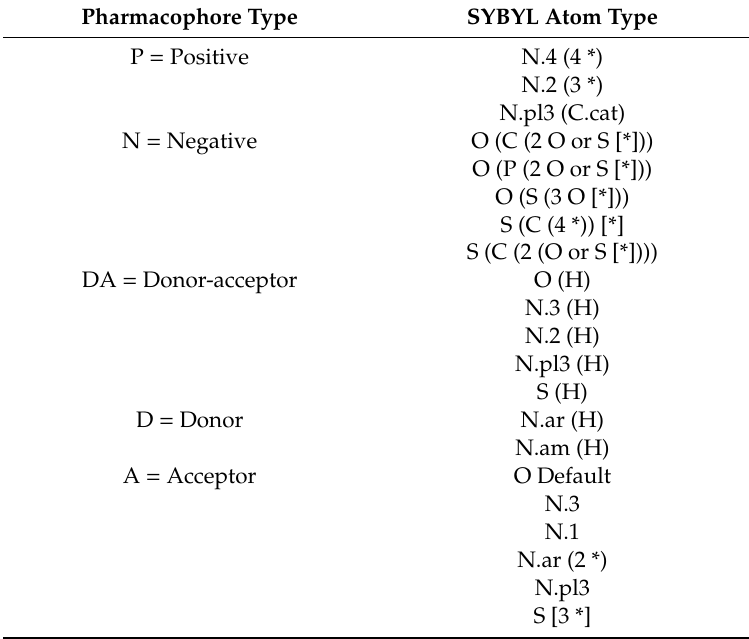
Table 2. Pharmacophore-type assignment equivalence. Parentheses and brackets indicate bond information: “( )” means atoms that must be bonded to the parent atom, while “[ ]” specifies atoms that must not be bonded. * indicates any